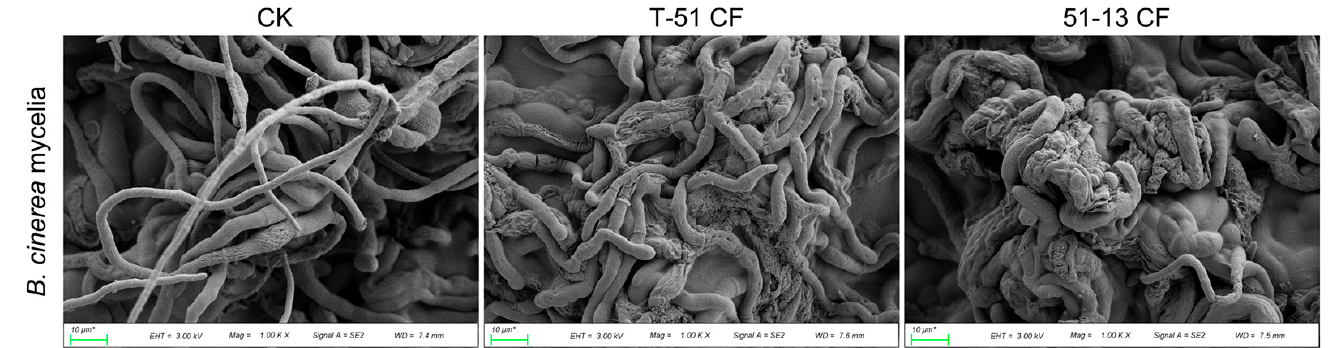
Figure 2. Inhibition of mycelial growth of various plant pathogenic fungi by the CF of T-51 and 51- 13. * p < 0.05; student’s t -test.